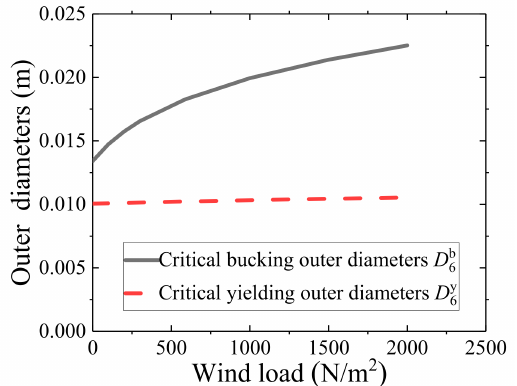
Figure 10. Required outer diameters of rod 6 under yielding and buckling